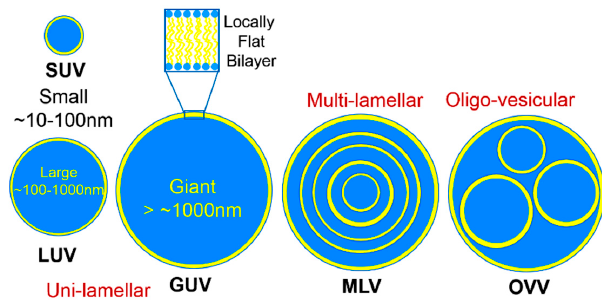
Figure 3. Types and schematic diagrams of vesicles (liposomes).